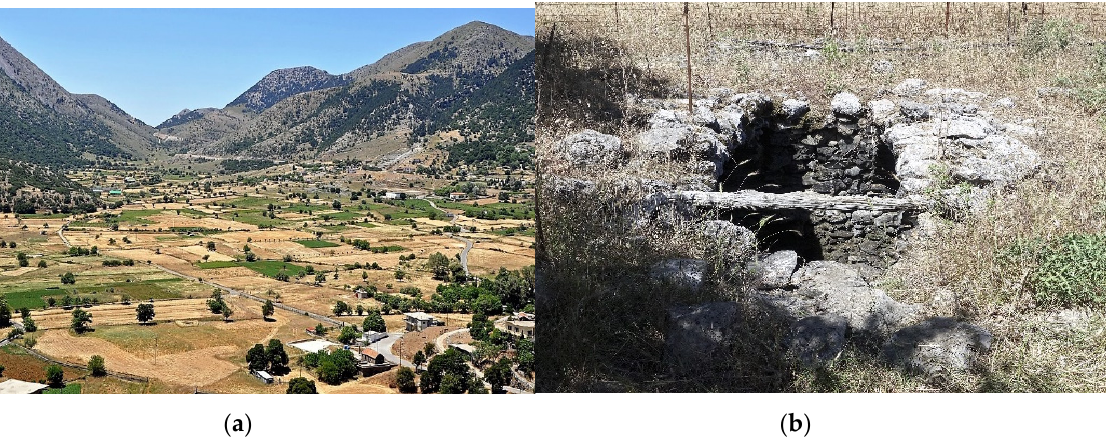
Figure 11. Askyfou: ( a ) plateau and ( b ) an ancient well in Askyfou (photos by A. N. Angelakis).